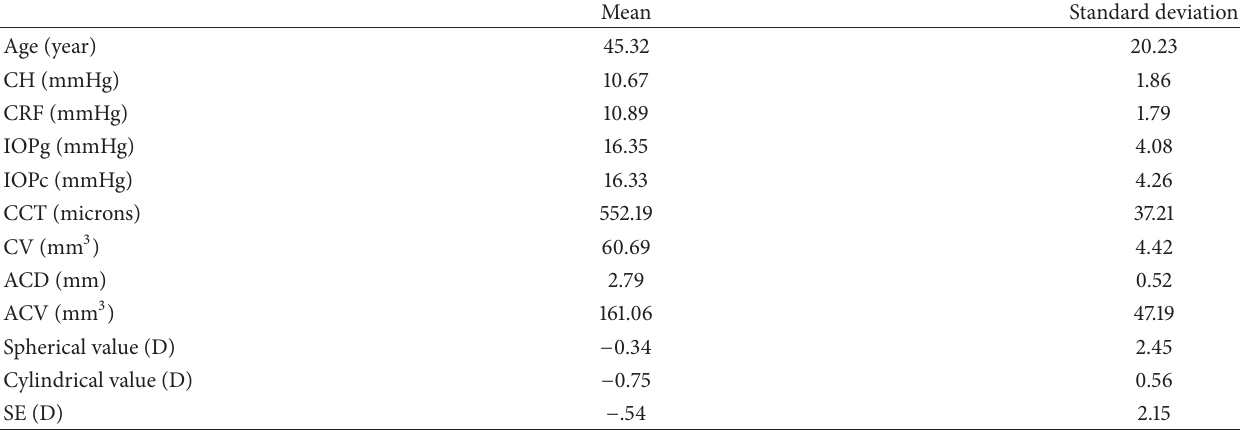
Table 1: The biomechanical properties, anterior segment parameters, and refraction values of healthy